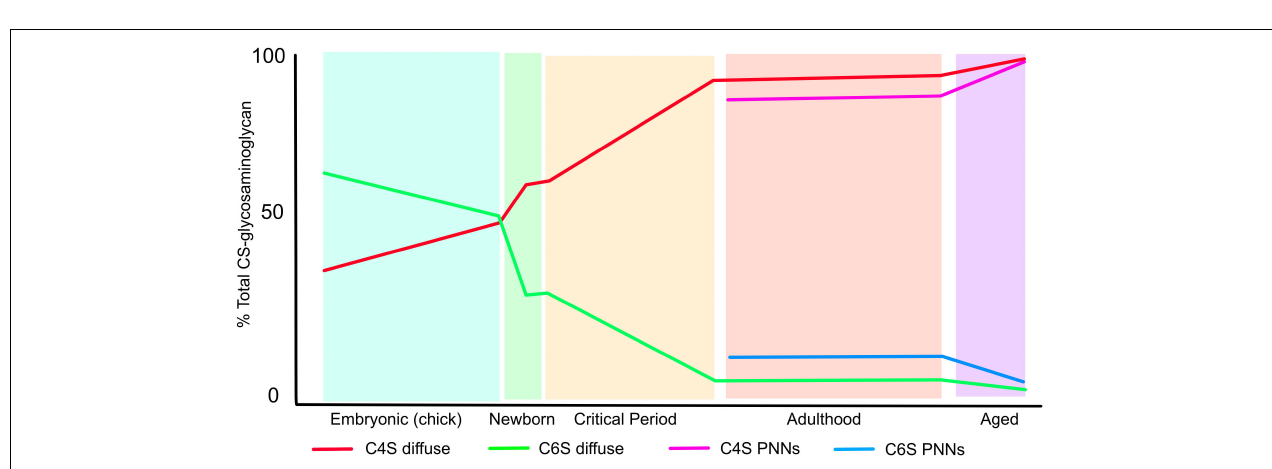
FIGURE 1 | Chemical structures of chondroitin sulphate and heparan sulphate. “R” in red denotes the potential sites for sulphations. These are C2 on glucuronic acid, C4 and C6 on N-acetyl galactosamine, and C3, C6 and the amine group on N-acetyl glucosamamine.